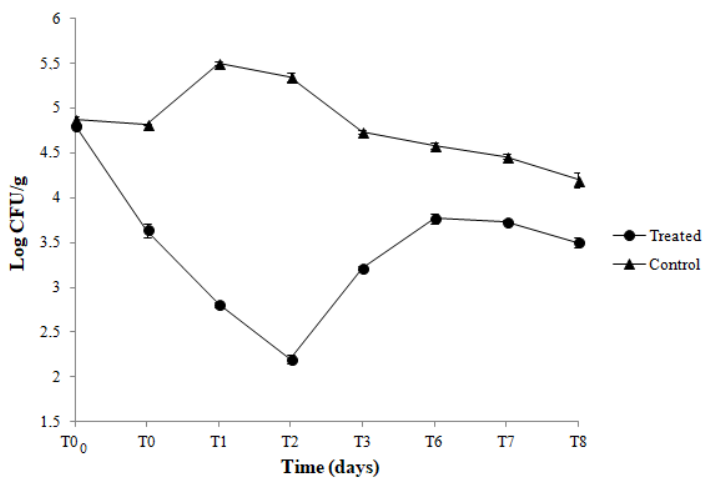
Figure 4. Viable counts of L. innocua population during the storage at 4 °C of hamburgers packed with CNF-Nis+PLA active films (treated) and CNF/PLA control films (control).